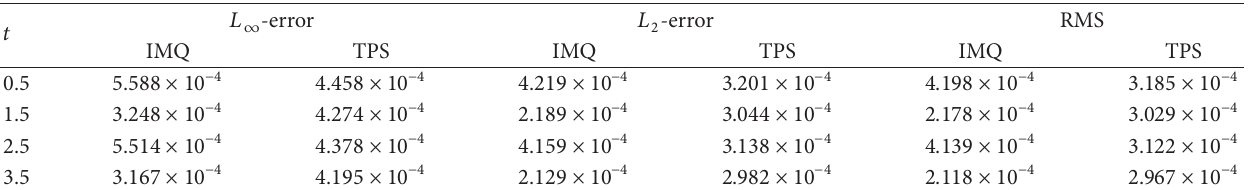
Figure 5: Space-time graph of numerical solutions at time 𝑡 = 1, 3 with 𝑑𝑥 = 0.01 , 𝑑𝑡 = 0.001 by using IMQ (with 𝑐 = 0.09 ) in Example 5 . Table 7: Numerical errors using IMQ ( 𝑐 = 0.06 ) and TPS ( 𝑚 = 2 ) represented at different times, where 𝑑𝑥 = 0.01 , 𝑑𝑡 = 0.001 , and 𝜃 = 1/2